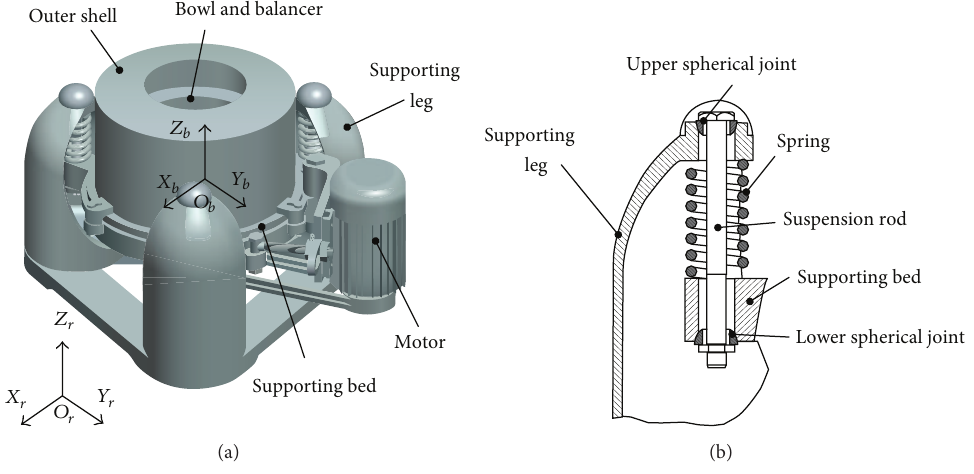
Figure 1: A three-column centrifuge (a) and its suspension structure